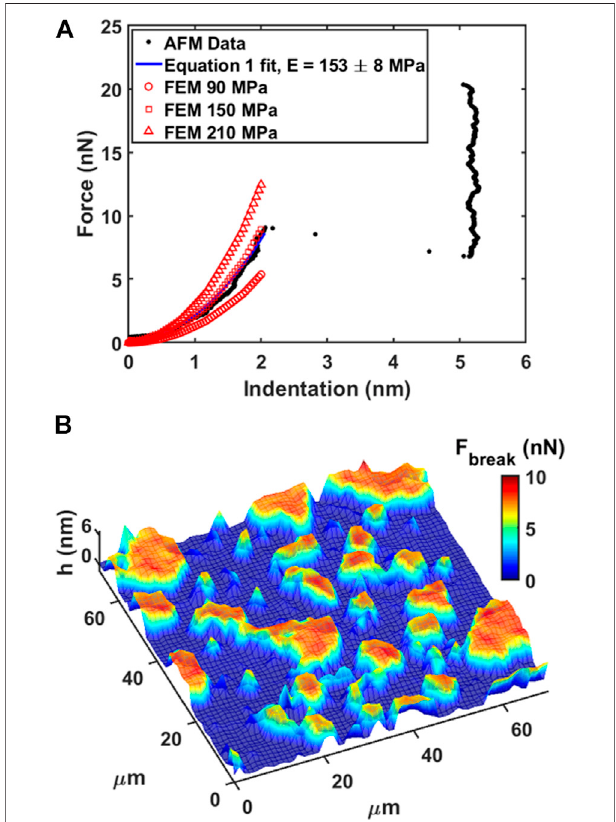
FIGURE 3 | Force spectroscopy and force volume on phospholipid bilayer. (A) Forcevs.Indentationwith fi ttingof Eq.1 andFEMsimulatedcurves overlapped. (B) 3D Map representation of 64 × 64 force volume grid by overlapping breakthrough force color map on morphology. Low ‘ h ’ thickness (blue color) represents substrate, while higher ‘ h ’ thickness (red color) represents the